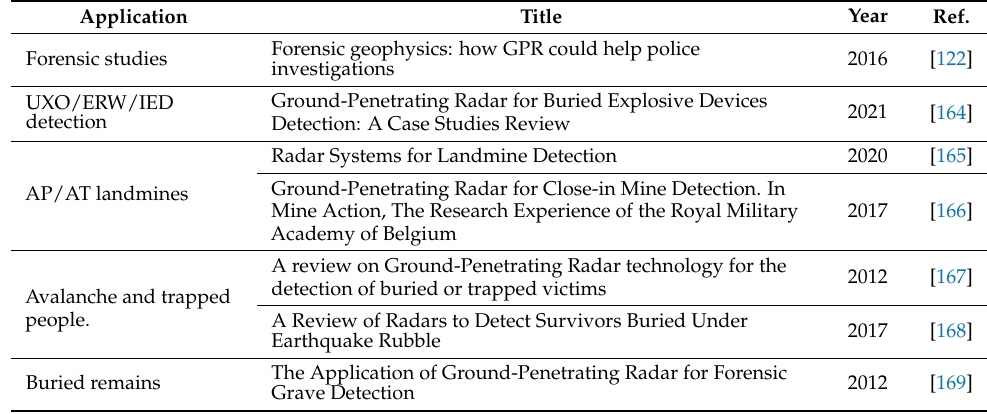
Table 3. Published review papers in forensic and security